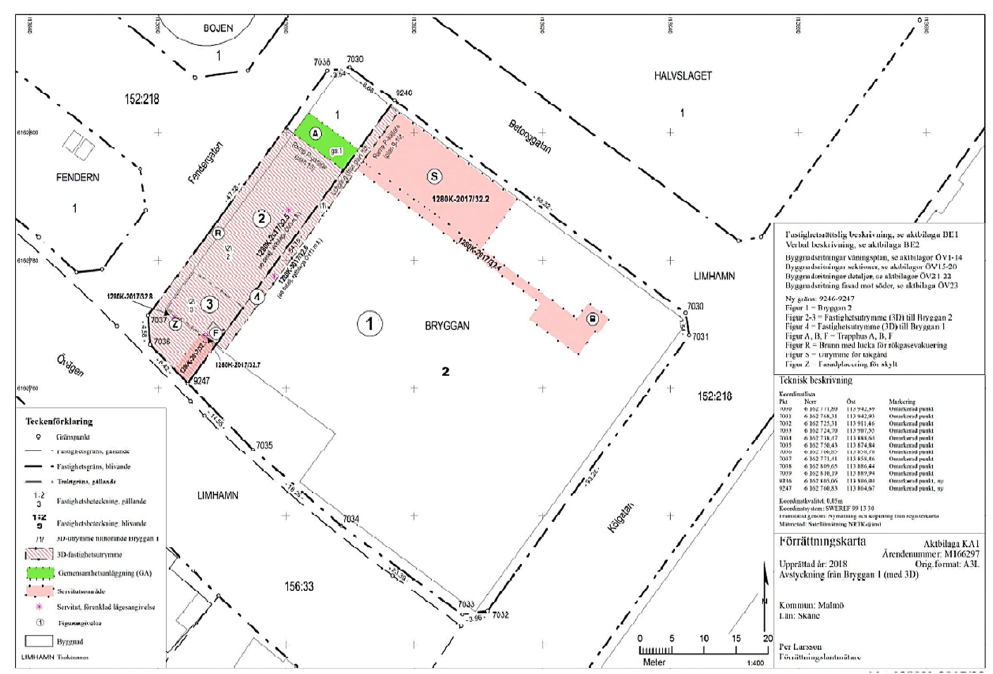
Figure 4. Cadastral map of Multihuset, Malmö, Sweden (Source: Malmö municipality).